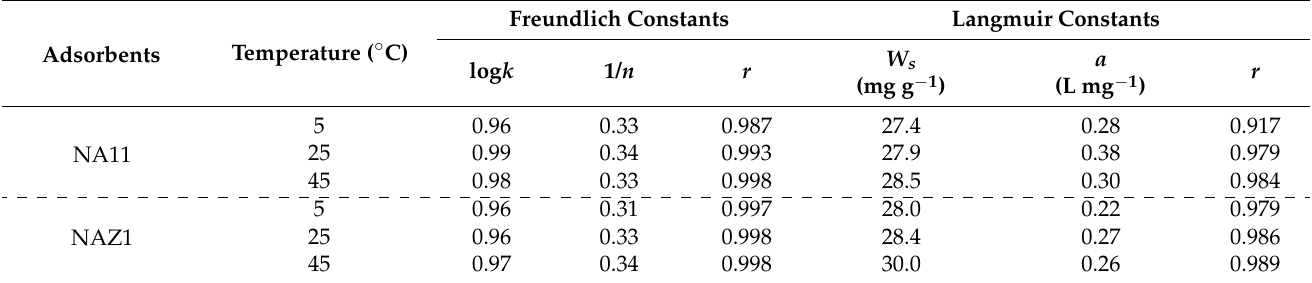
Table 3. Freundlich and Langmuir constants for the adsorption of